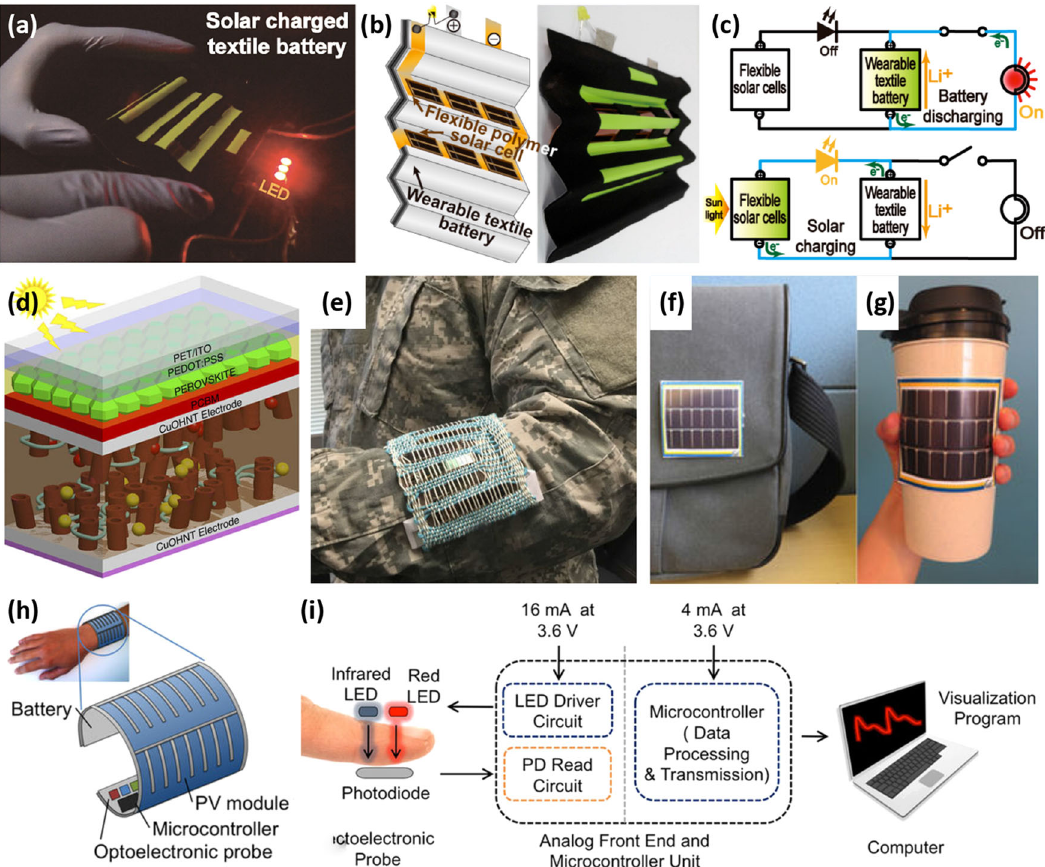
Fig. 9 Self-powered packs (SPP). a Photograph and b corresponding 3D schema of fl exible solar cell and battery integrated forming a fl exible SPP. c Diagram of SPP working principle. Reprinted with permissions from Lee et al. 166 Copyright © 2013, American Chemical Society. d 3D schema of a SPP consisting of a perovskite PV cell and a SC. e Photograph showing a military uniform incorporating a lightweight fabric woven SPP and cotton threads. Reprinted with permission from Li et al. 56 Copyright © 2016, Springer Nature. Photographs of a fl exible SPP consisting of a fl exible PV cell and a LiB wrapped on a f bag and g a travel mug. h 3D schema and i working principle of a pulse oximeter powered by a SPP. Reprinted with permission from Ostfeld et al. 195 Copyright © 2016, Springer